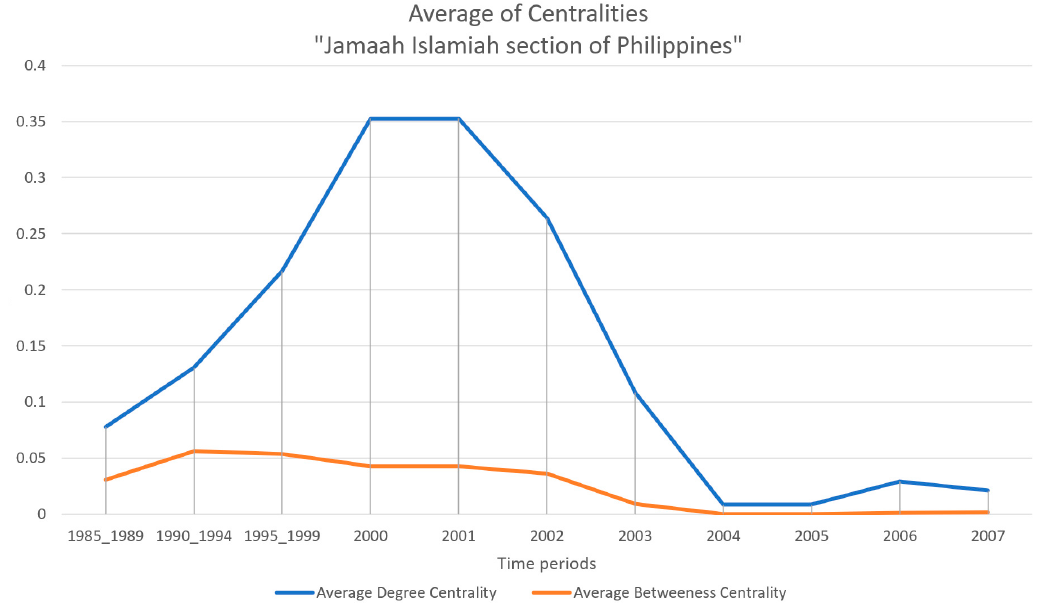
Figure 16. Temporal development of average degree centrality and average betweenness centrality for the “Jamaah Islamiah section of Philippines”. Both indices increase, reach a maximum and then decrease. The average degree centrality reaches a maximum in 2000 and rapidly decreases from 2001 to 2004; it starts increasing slowly again one year later. The average betweenness centrality reaches a maximum in 1994, decreases slowly up to 2002 and then rapidly decreases to zero by 2004, without increasing again afterwards.